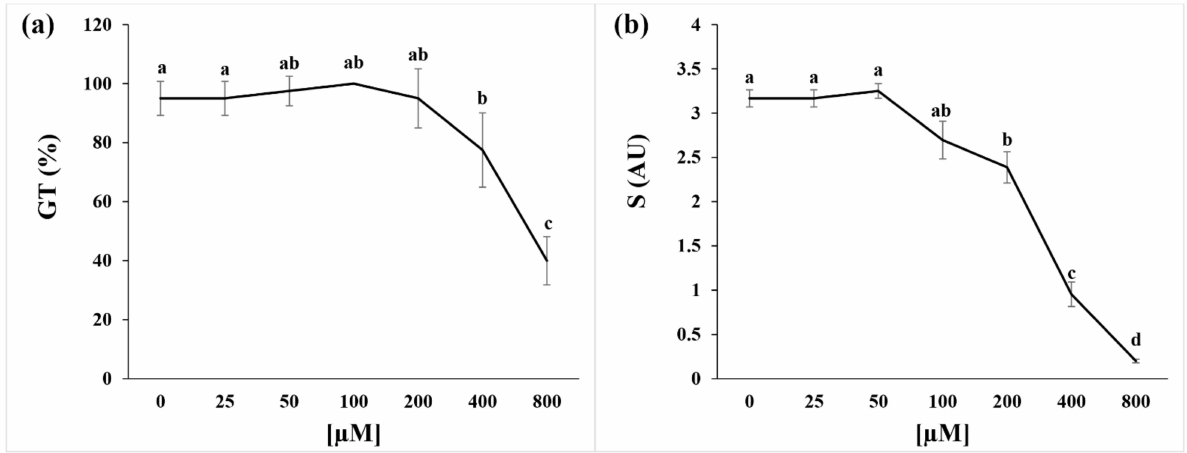
Figure 1. Dose–response curves of the ( a ) germination index (GT(%)) and ( b ) germination speed (S; Arbitrary Unit, AU) of R. sativus seeds treated for 48 h with 0–800 µ M of coumarin. Data are expressed as mean ± SD and analysed through one way ANOVA using the LSD test as post hoc ( p ≤ 0.05). Different letters along the bars indicate statistical differences among the treatments. N = 4. Since 400 µ M was the first significant concentration able to inhibit seed